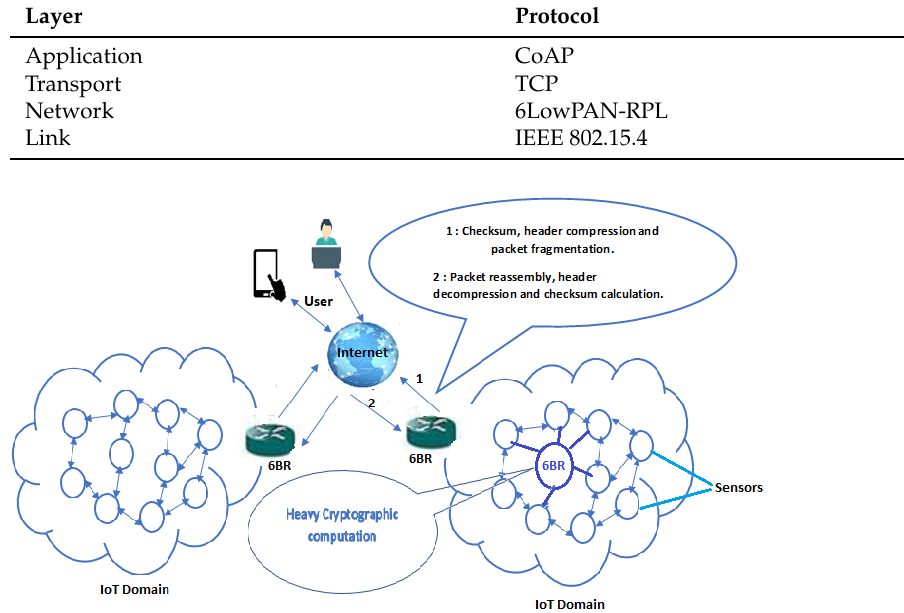
Figure 8. Adopted 6LoWPAN-based IoT architeture.